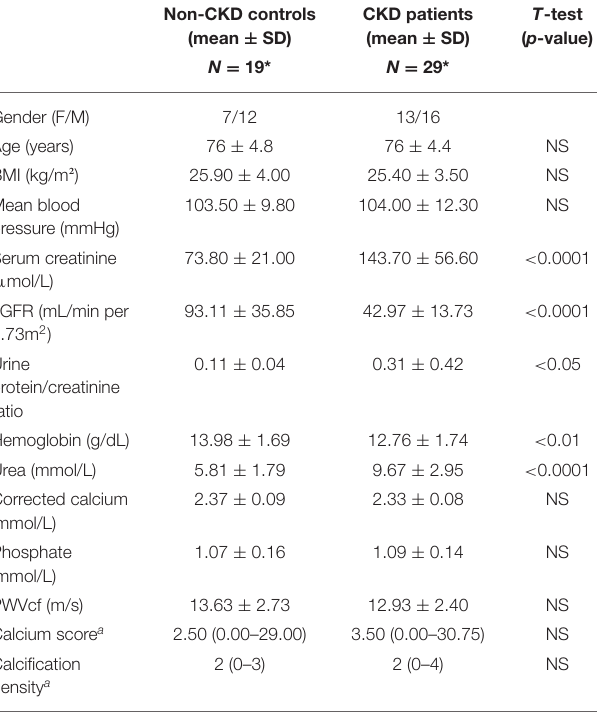
BMI, body mass index; eGFR, estimated glomerular filtration rate; PWVcf, carotid-femoral pulse wave velocity; NS, not significant. a Median and interquartile range; * n = 16 for non-CKD, n = 22 for CKD patients with valid calcium score